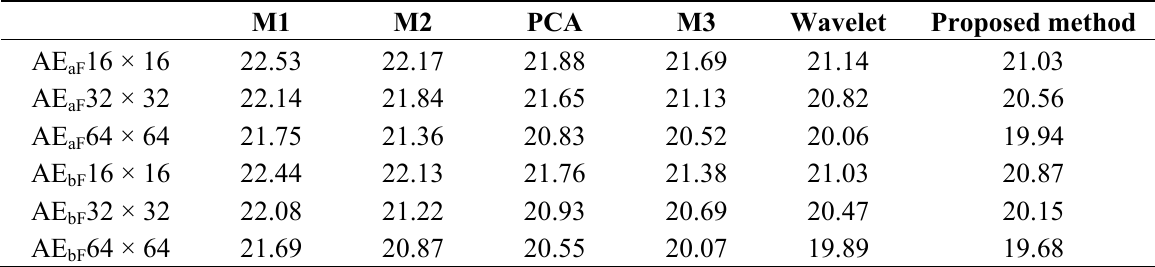
Table 7. ESAM values between visible, infrared and fused